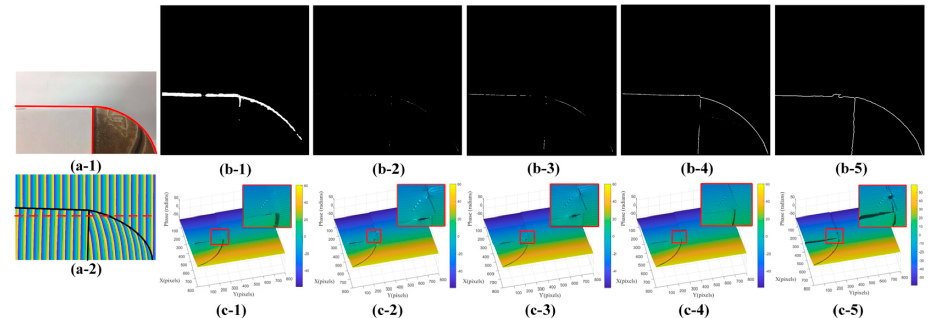
Figure 6. Results of an experimental fringe pattern from fringe projection profilometry: ( a - 1 ) a real scene; ( a - 2 ) the wrapped phase image; ( b - 1 – b - 5 ) weight mask’s segmentation results of OC, DVCM, PLDV, RM, and the proposed algorithm; ( c - 1 – c - 5 ) 3D reconstructed absolute phase. The computational times of the five algorithms for the real scene are tabulated in Table 3. Table 3. Computational time of five algorithms for real scene (Figure 6a ‐ 1) .